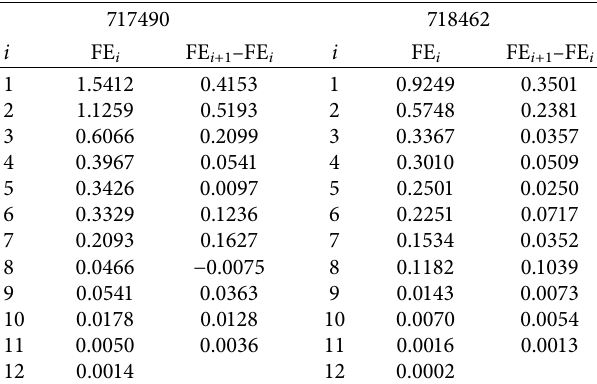
Figure 7: IMF and residual of (a) 717490 and (b) 718462. Table 2: IMF FE and the FE difference of 717490 and